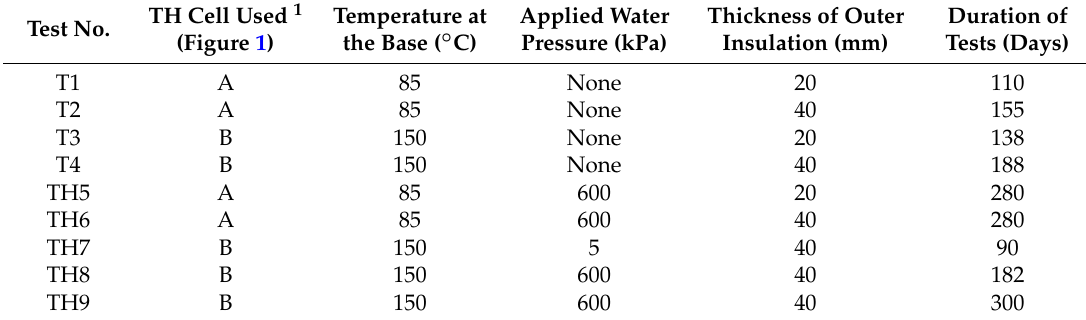
Table 1. Details of the non-isothermal and non-isothermal hydraulic tests carried out in this study. Temperature at Applied TH Cell Used 1 Test No. the Base ( ◦ C) (Figure 1)